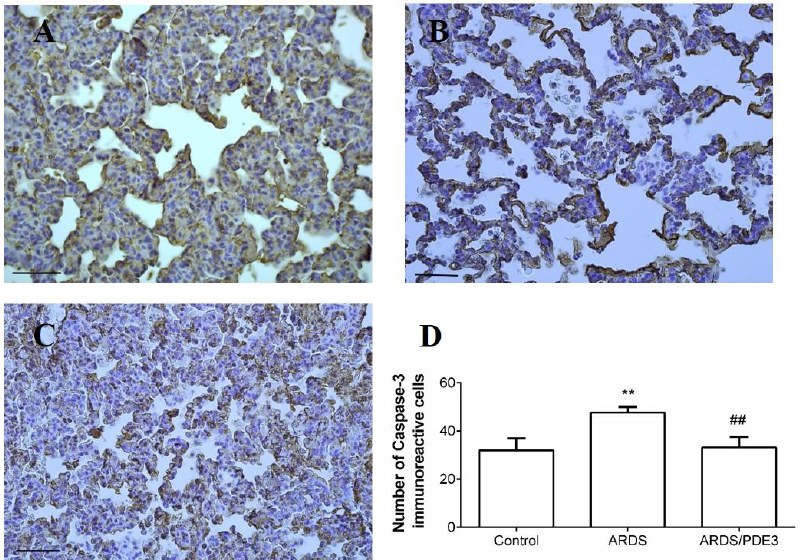
Figure 4. Apoptosis of lung epithelial cells visualized by caspase-3 immunohistochemical staining after the 4h therapy. Representative microphotographs of the lungs of healthy controls ( A ); animals with non-treated ARDS ( B ) and animals with ARDS treated with olprinone ( C ) using the TUNEL method for detection of apoptosis , scale bars: 50 μm . ( D ) Relative values of the activated caspase-3 immunoreactive alveolar cells. Statistical comparisons: for ARDS vs. Control ** p < 0.01; for ARDS/PDE3 vs. ARDS ## p < 0.01. Data are presented as means ± SEM.